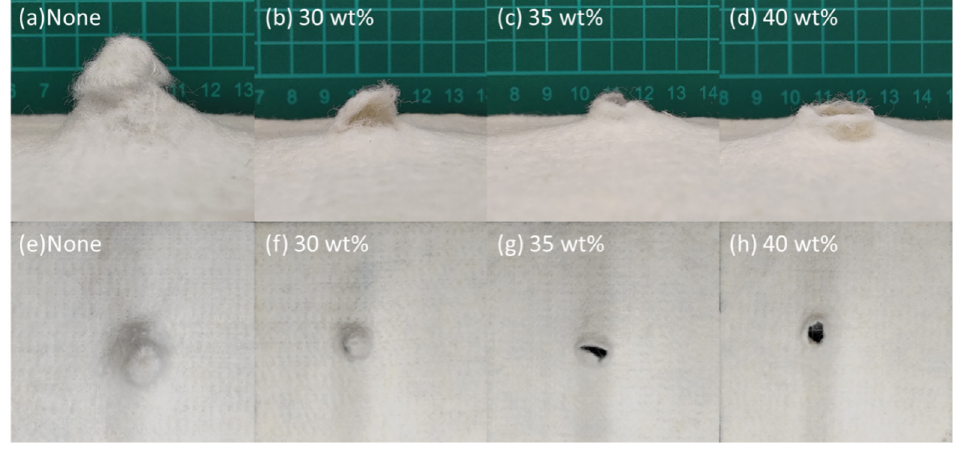
Figure 12. Images of samples after the dynamic impact test: ( a–d ) the lateral view; ( e–h ) the top view.